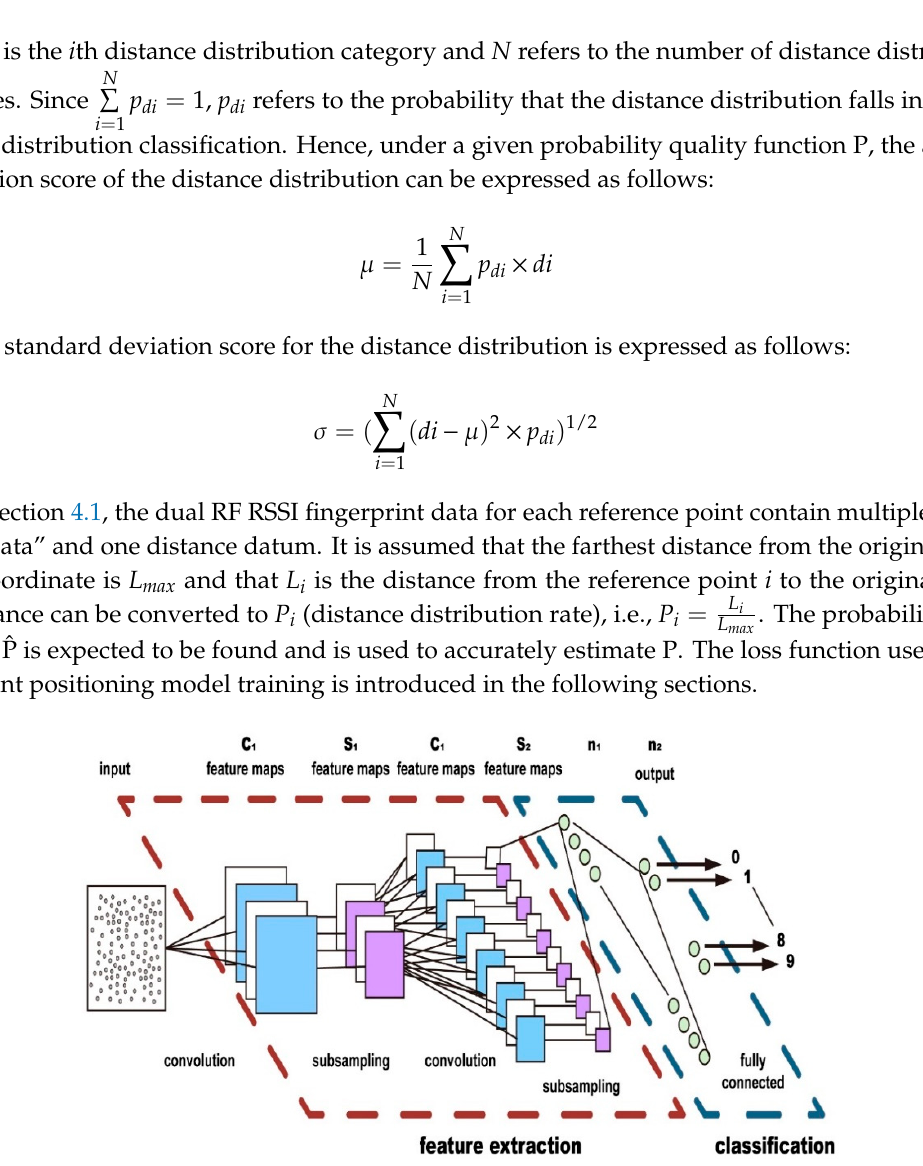
Figure 6. CNN structure diagram of model.